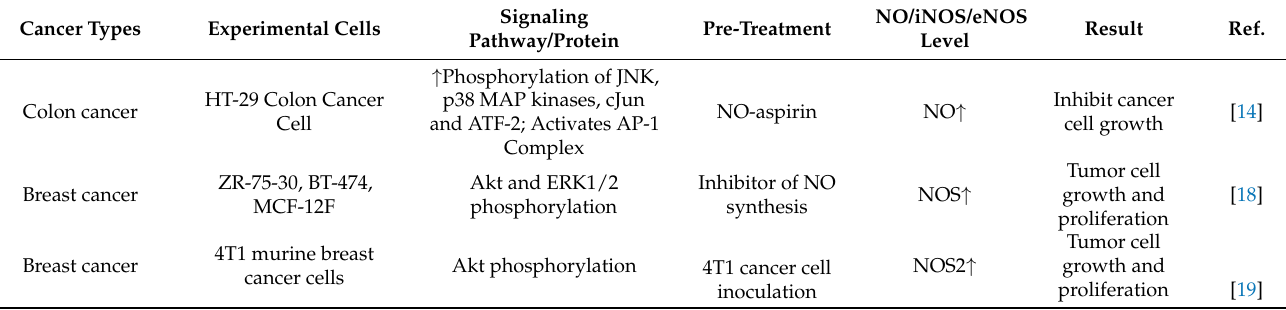
Table A1. The impact of the NO pathway on partial pathways and proteins in different types of cancer. Cancer